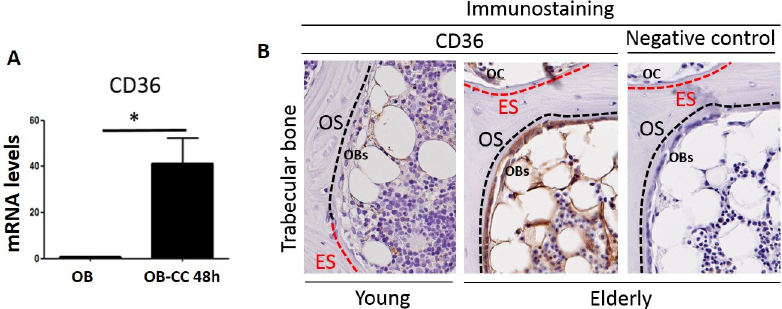
Fig 6. Immunohistochemical analysis confirmed the presence of an adipogenic marker (CD36) in mature osteoblasts in elderly subjects but not in the young subject. (A) CD36 mRNA expression levels in OB and OB-CC cells after 48 h of coculture. mRNA expression levels were normalized to OB expression against the signal from two housekeeping genes, peptidylprolyl isomerase A (PPIA) and tyrosine 3-monooxygenase/tryptophan 5-monooxygenase activation protein (YWHAZ). Graphs are representative of 4 independent experiments performed in duplicate. Error bars show the standard deviation. � P � 0.05, cocultured osteoblasts (OB-CC) compared to osteoblasts grown alone (OB). (B) CD36 immunoreactivity (brown) in human iliac bone biopsy specimens from young and elderly women. Illustrations show the CD36-positive osteoblasts (OBs) on osteoid surfaces (OS) of trabecular bone from an elderly woman and comparable CD36-negative osteoblasts from a young woman. In both the young and elderly women, CD36-positive vascular structures are present, while adipocytes in the marrow cavity appear more CD36-positive in the elderly woman than in the young woman. In the elderly woman, weak staining was also observed in osteoclasts (OC) on eroded surfaces (ES).